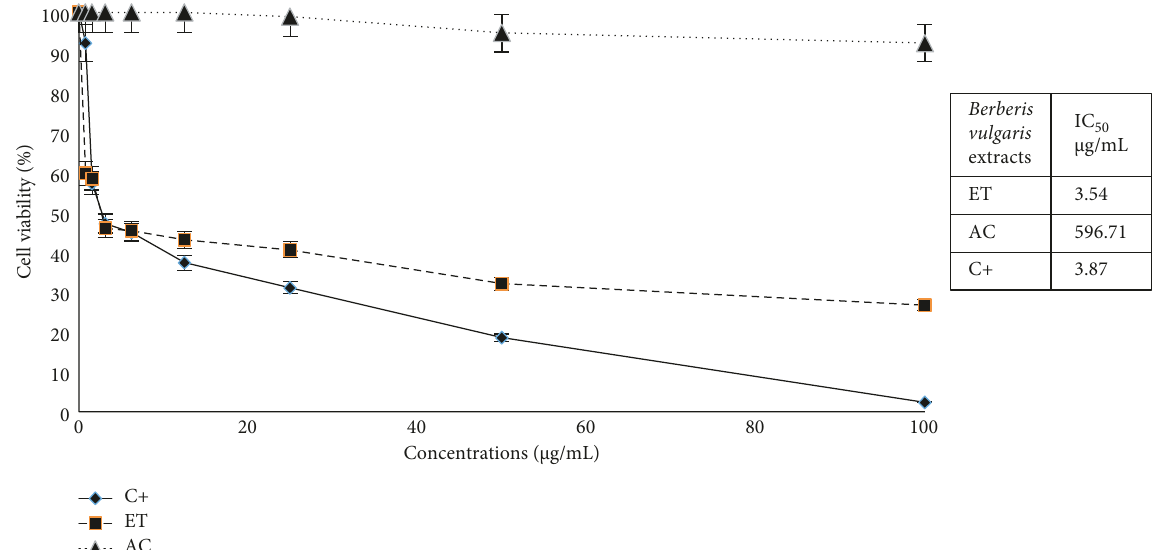
Figure 1: Cytotoxic effect and IC 50 values of different concentrations of Berberis vulgaris extracts against the MCF-7 tumour cell line. ET: ethanol extract, AC: ethyl acetate extract, C+: cis-platin.